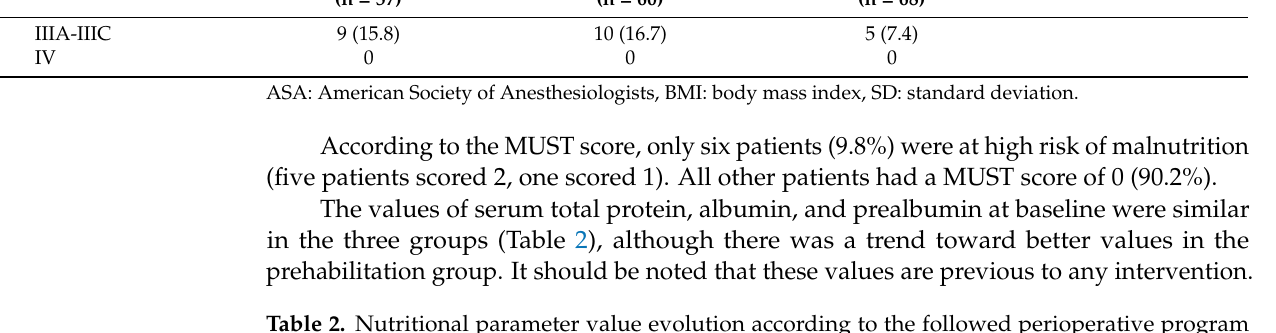
Table 2. Nutritional parameter value evolution according to the followed perioperative program (preERAS vs. ERAS vs. Prehab).